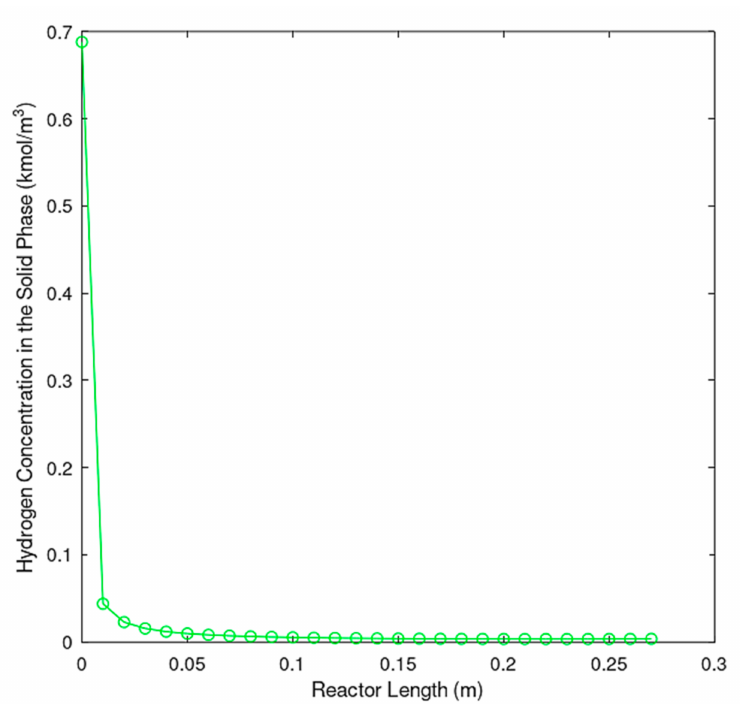
Figure 9. Hydrogen concentration in the solid